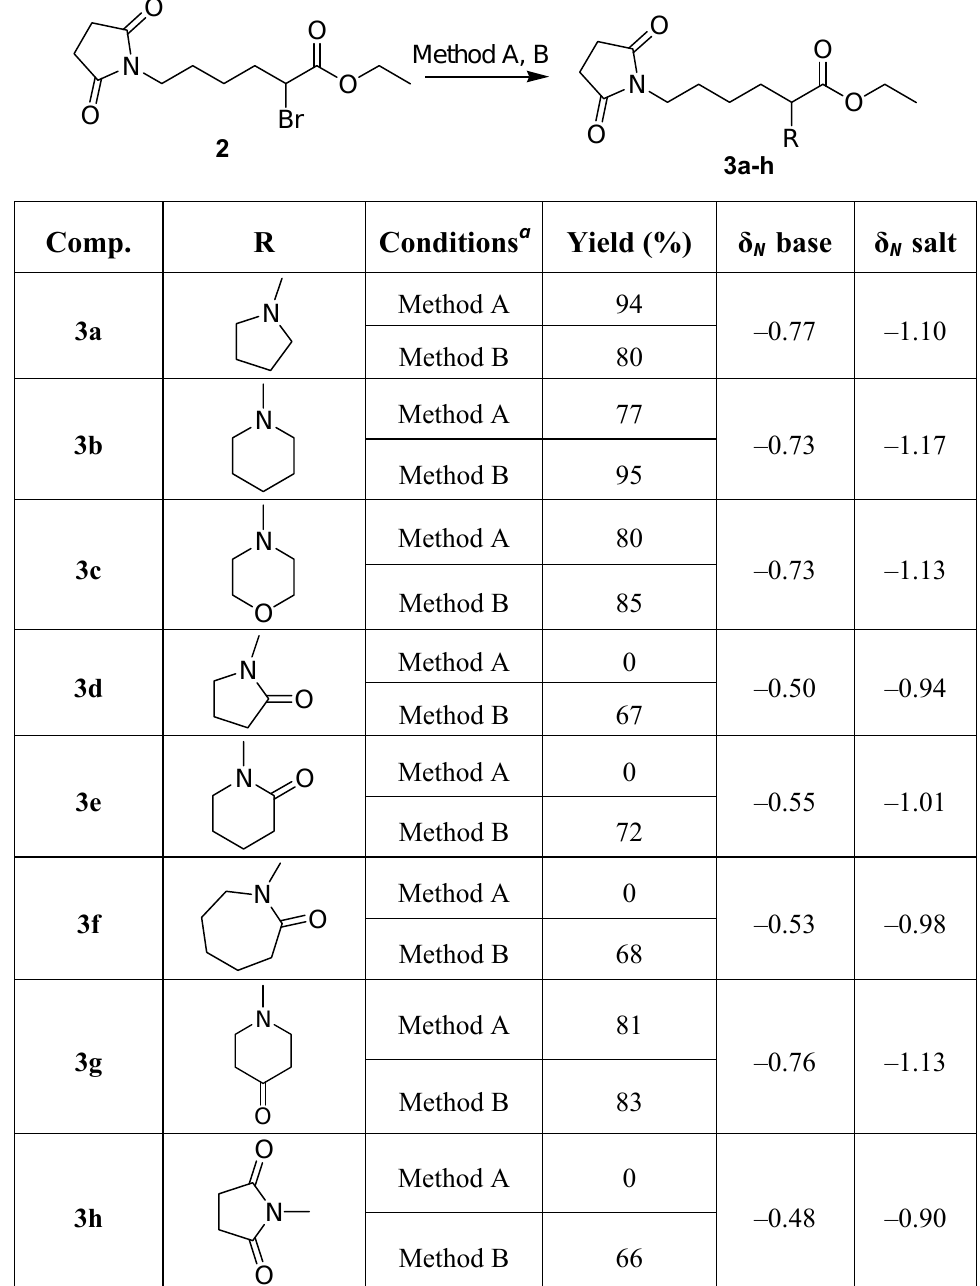
Table 1. The C-N coupling reactions of compound 2 with nitrogen-containing heterocycles and calculated partial charges on nitrogen atoms ( δ sodium salts in dry